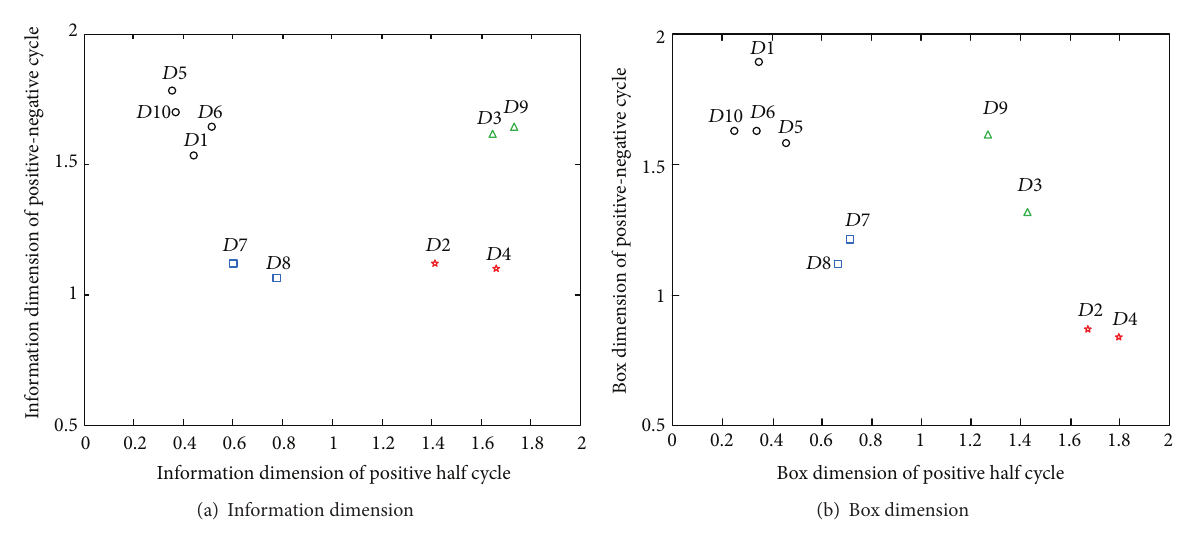
Figure 9: Fractal characteristics of testing